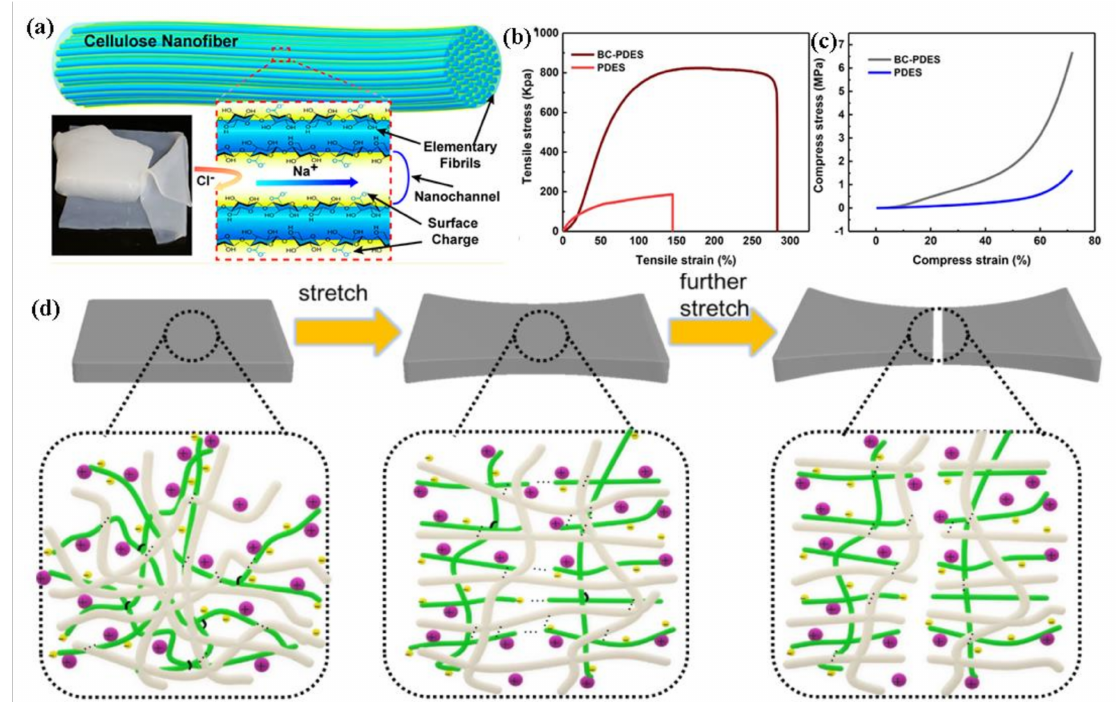
Figure 8. ( a ) The TEMPO treatment process significantly imparts negative surface charge on the cellulose nanofibers for highly selective cation transport and photographs of the hydrated pristine BC. Reproduced with permission from [76]. Copyright 2018, American Chemical Society; ( b ) typical tensile stress/strain curves, ( c ) compressive stress/strain curves of BCs-PDESs and PDESs, ( d ) possible energy dissipation mechanism of the double polymer chain network under stretching. Reproduced with permission from [77]. Copyright 2020, American Chemical